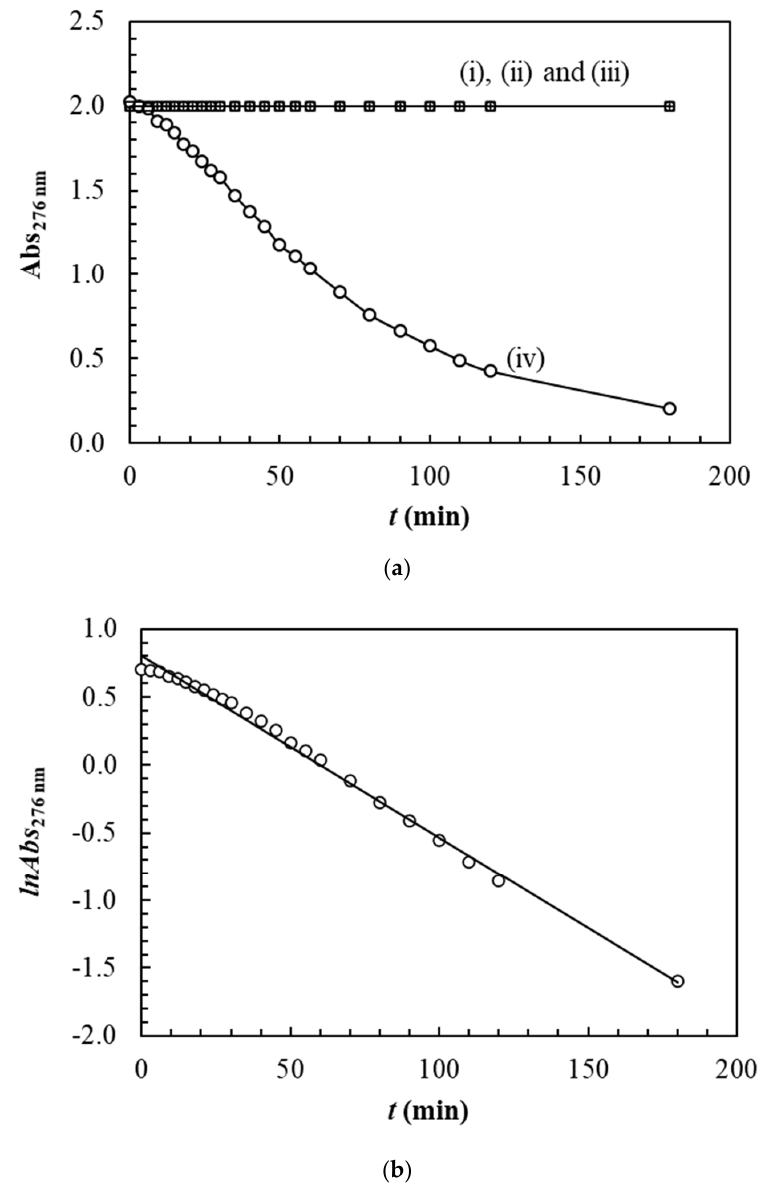
Figure 6. ( a ) Plots of A 276nm vs. t for CPF degradation in aqueous solution for various control experiments: (i) 50 µM CPF + CS-GLA immobilized on a glass plate + solar light; (ii) 50 µM CPF + Fe ӀӀӀ -CS-GLA immobilized on a glass plate + solar light; (iii) 50 µM CPF + Fe ӀӀӀ -CS-GLA immobilized on a glass plate + H 2 O 2 + dark; (iv) 50 µM CPF + Fe ӀӀӀ -CS-GLA immobilized on a glass plate + H 2 O 2 + solar light. ( b ) Plot of lnA 276nm vs. t for oxidative degradation of CPF in aqueous solution at optimum condition (control (iv)). Experimental conditions: [CPF] 0 : 50 µM; [Fe ӀӀӀ ] 0 in Fe III -CS-GLA: 1.25 mM; [GLA] 0 in Fe III -CS-GLA: 90 mM; [H 2 O 2 ] 0 : 6 mM; volume of CPF solution: 250 mL; pH: 3; light intensity: 70,000–90,000 Lux; solar light irradiation time: 180 min.